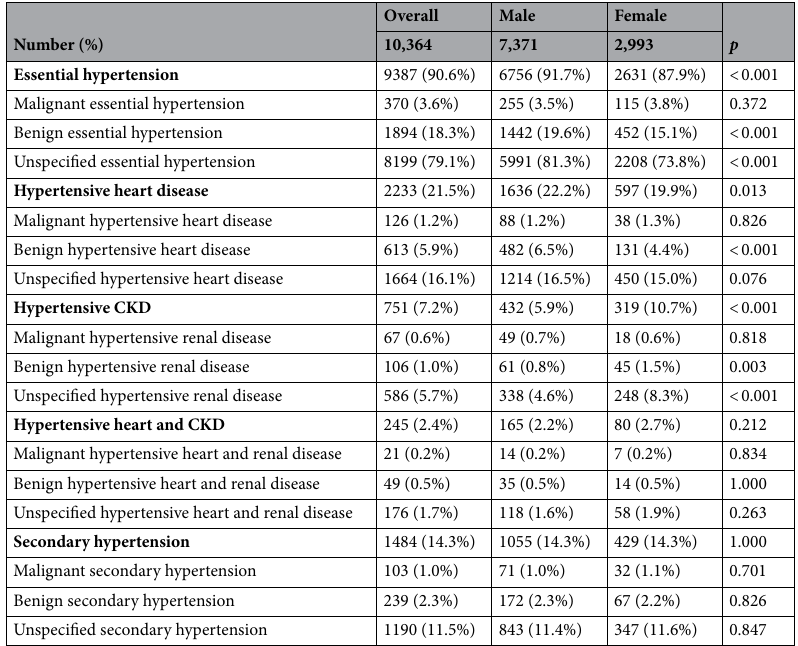
Table 4. Distribution in subcodes of each hypertension among children and adolescents according to ICD- 9-CM. CKD chronic kidney disease, ICD-9-CM International Classification of Diseases, Ninth Revision, Clinical